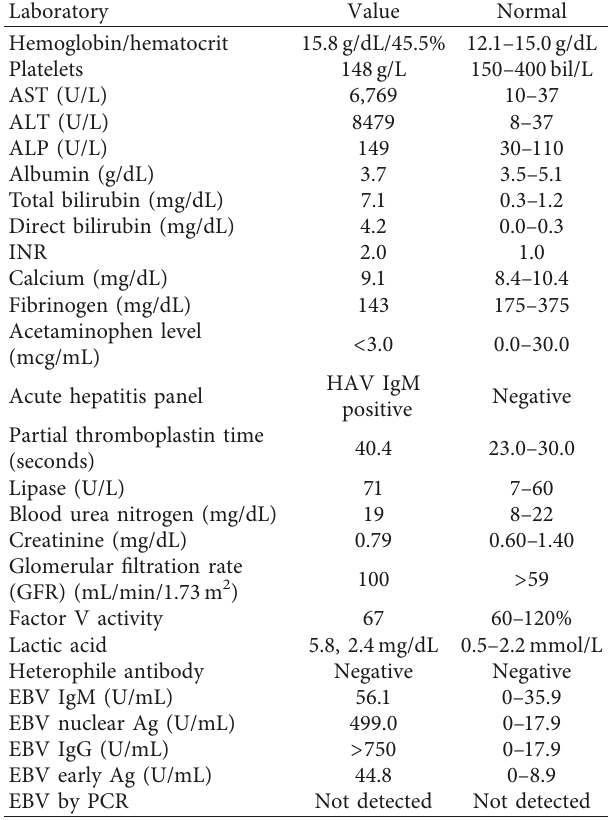
Table 1: Key laboratory values on admission.